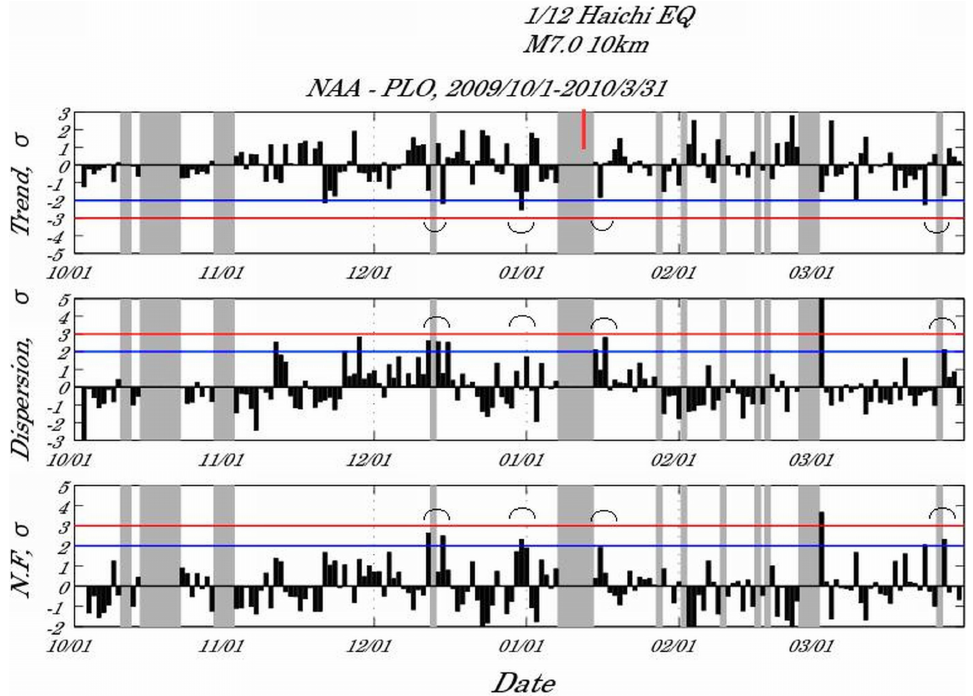
Fig. 2. Temporal evolutions of three physical parameters of VLF propagation characteristics (from the top, trend (mean nighttime amplitude), dispersion and NF (nighttime fluctuation)). All of these parameters are normalized with the corresponding standard deviation ( σ ) before the current day ( − 30 to − 1day of the current day). Grey areas indicate no observation. The date is from the beginning of 2009 to the end of March 2010, and EQ occurrence day is located approximately in the middle of our period. Of particular interest are the periods when the trend is decreased and the dispersion and NF show nearly simultaneous